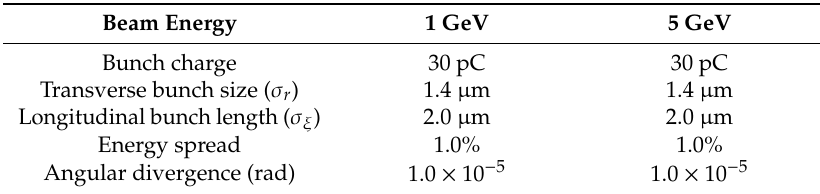
Table 1. EuPRAXIA beam parameters used in